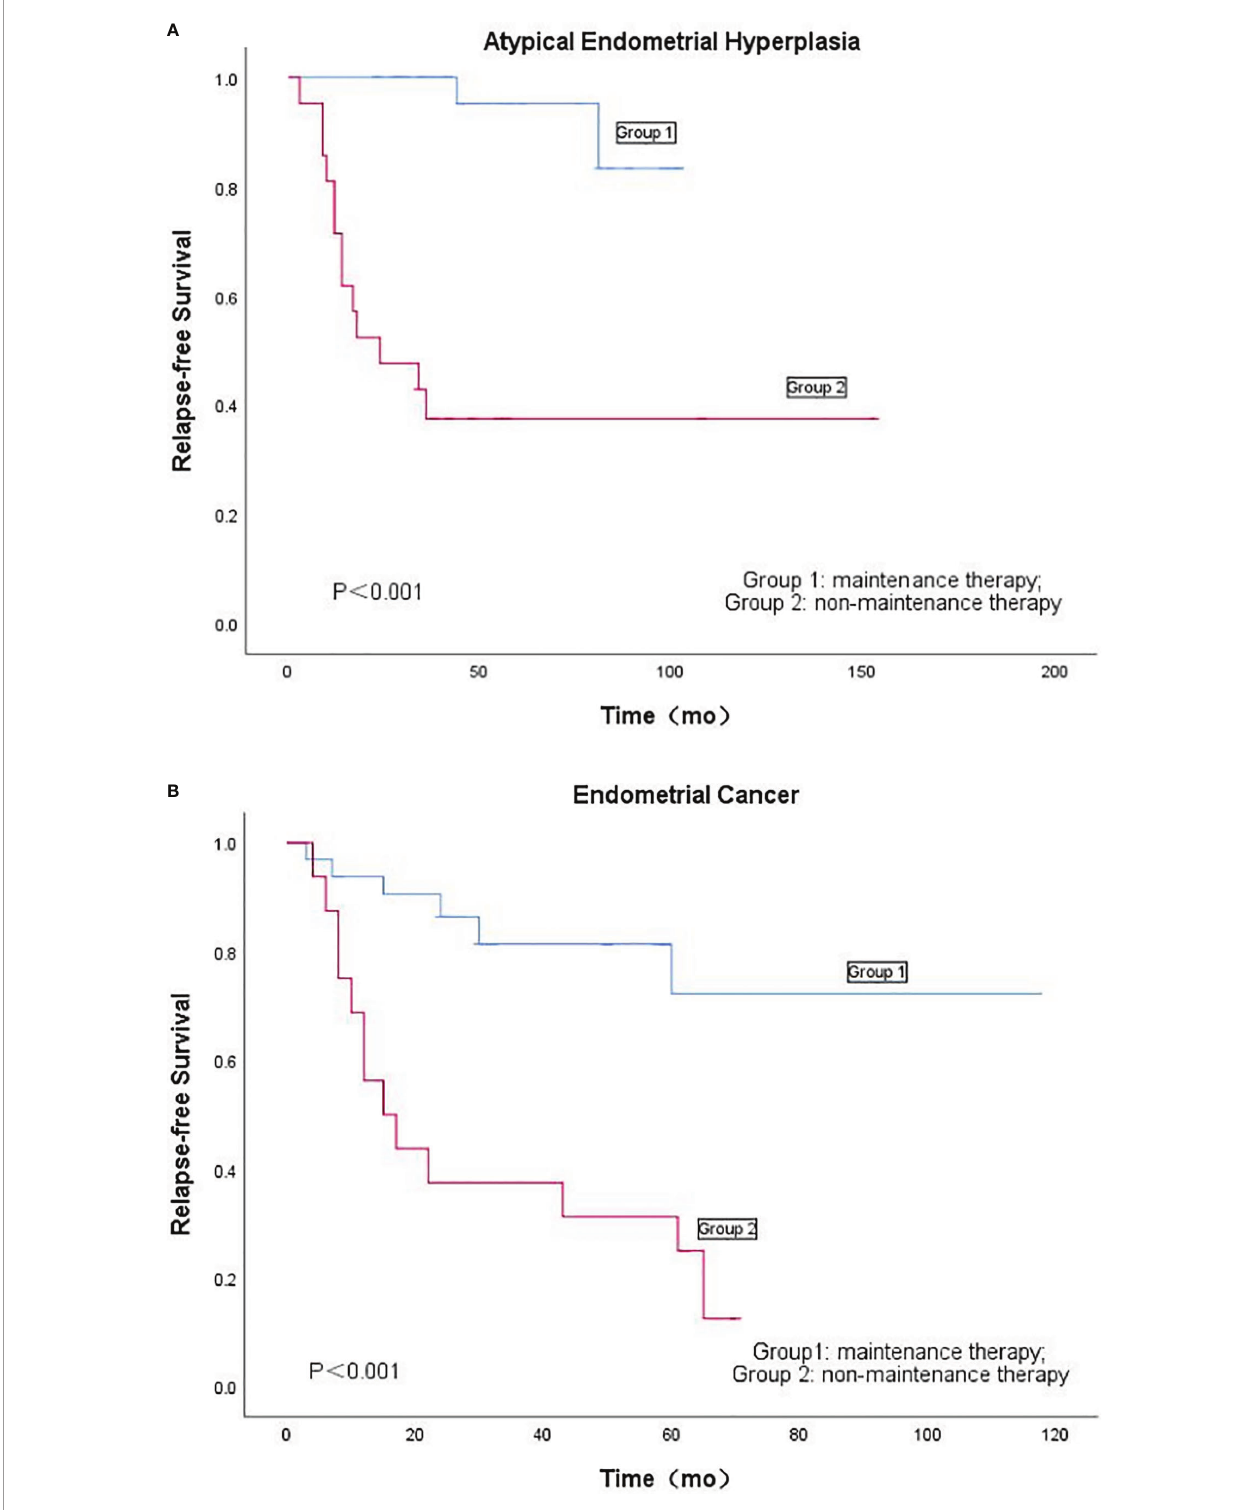
FIGURE 2 | (A) : Kaplan-Meier ’ s analysis of the effect of maintenance therapy on recurrence of patients with atypical endometrial hyperplasia. (B) Kaplan-Meier's analysis of the effect of maintenance therapy on recurrence of patients with endometrial